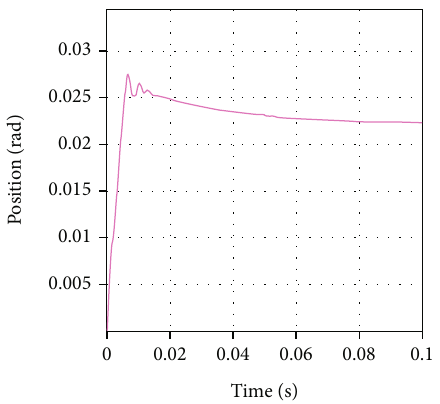
Figure 20: Position estimation errors using proposed method.